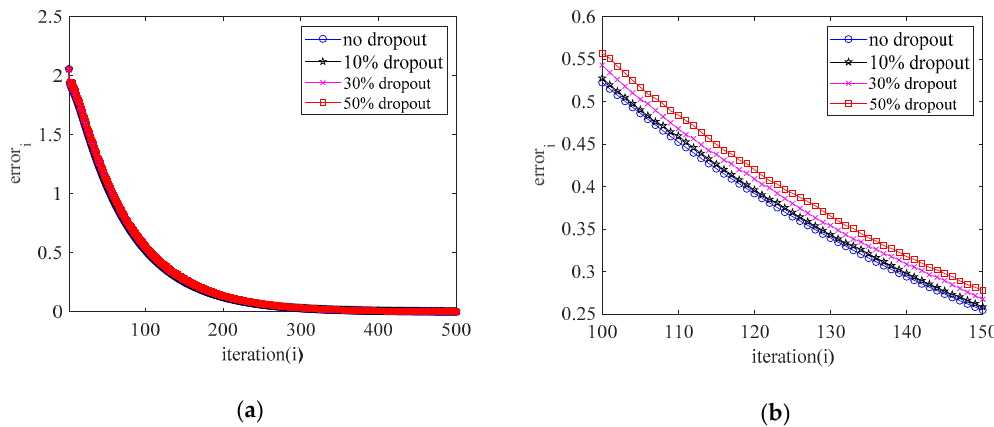
Figure 7. Trajectory of the multi-agent system without packet loss compensation at iteration 500.